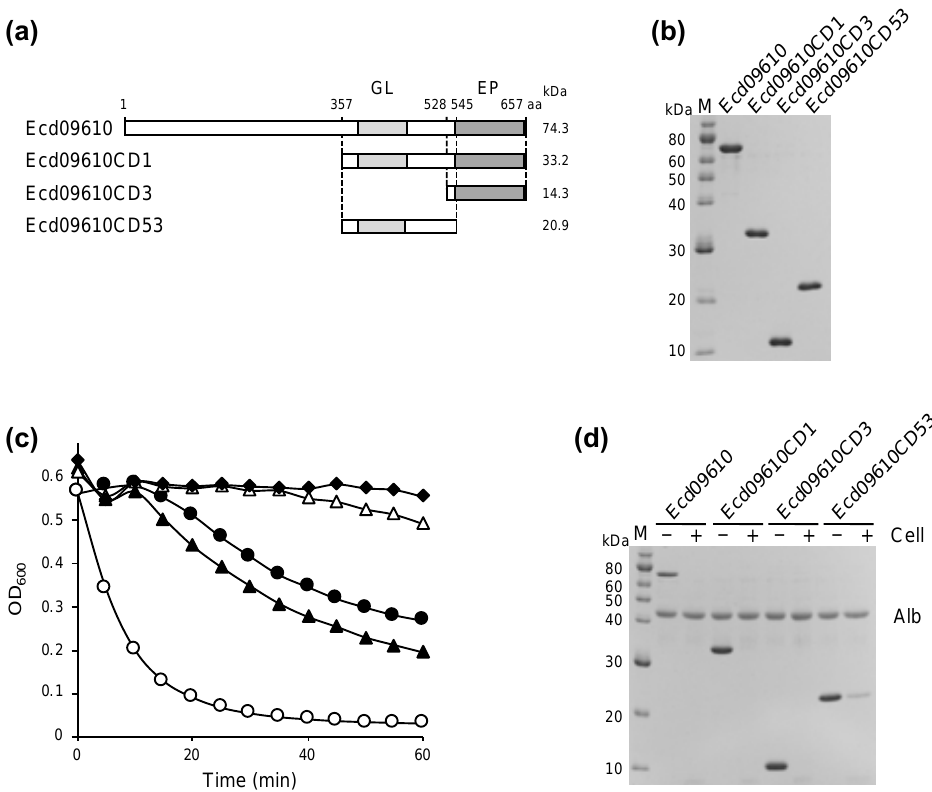
Figure 1. SDS-PAGE analysis, lytic activities, and binding ability of Ecd09610, Ecd09610CD1, Ecd09610CD3, and Ecd09610CD53. ( a ) Schematic diagrams of Ecd09610, Ecd09610CD1, Ecd09610CD3, and Ecd09610CD53. Ecd09610 has two catalytic domains of glucosaminidase (GL) and endopeptidase (EP) at the C-terminus. These proteins have His-tags at the N-terminus. ( b ) SDS-PAGE analysis of purified Ecd09610, Ecd09610CD1, Ecd09610CD3, and Ecd09610CD53 (1 µ g each). The gel was stained with Coomassie blue R. ( c ) Lytic activities of protein (0.1 µ M) were determined by the turbidity reduction assay against C. difficile 630 cells. Ecd09610 (filled circles), Ecd09610CD1 (open circles), Ecd09610CD3 (filled triangles), Ecd09610CD53 (open triangles), and control (filled diamond) are shown. ( d ) Binding ability of purified proteins to C. difficile 630 cells. Purified protein and nonbinding internal standard (ovalbumin: Alb) were incubated with (+) or without ( − ) cells. After centrifuging samples, supernatants were analyzed by 13.5%